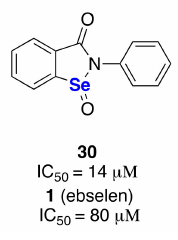
Figure 5. Structure of IC 50 for alginate inhibition.